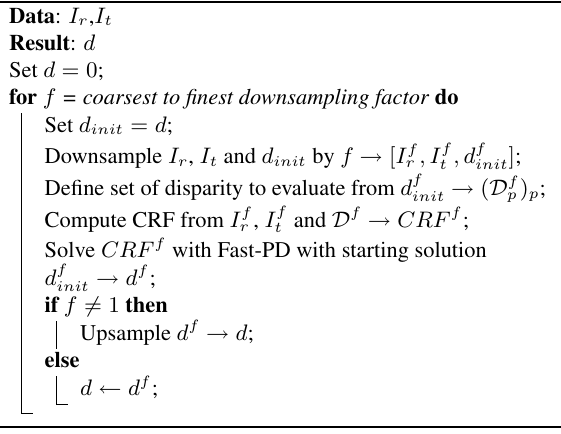
Algorithm 1: Image pyramid, the GM-IP algorithm